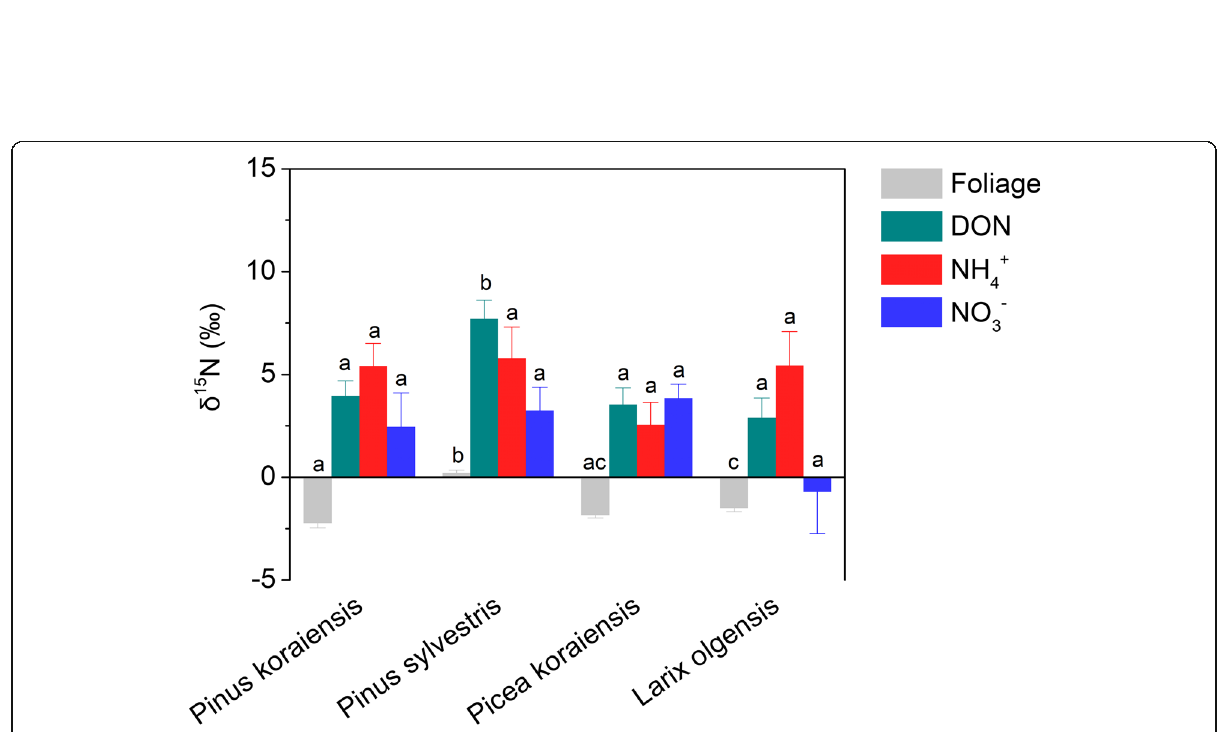
Fig. 3 δ 15 N values of foliage and of soil DON, NH 4+ , and NO 3 − in 0 – 20 cm mineral soil (means ± SE, n = 5) in the four forest plantations. Different letters on bar of the same color indicate significant differences among four forest plantations in their δ 15 N values (one-way ANOVA, P <